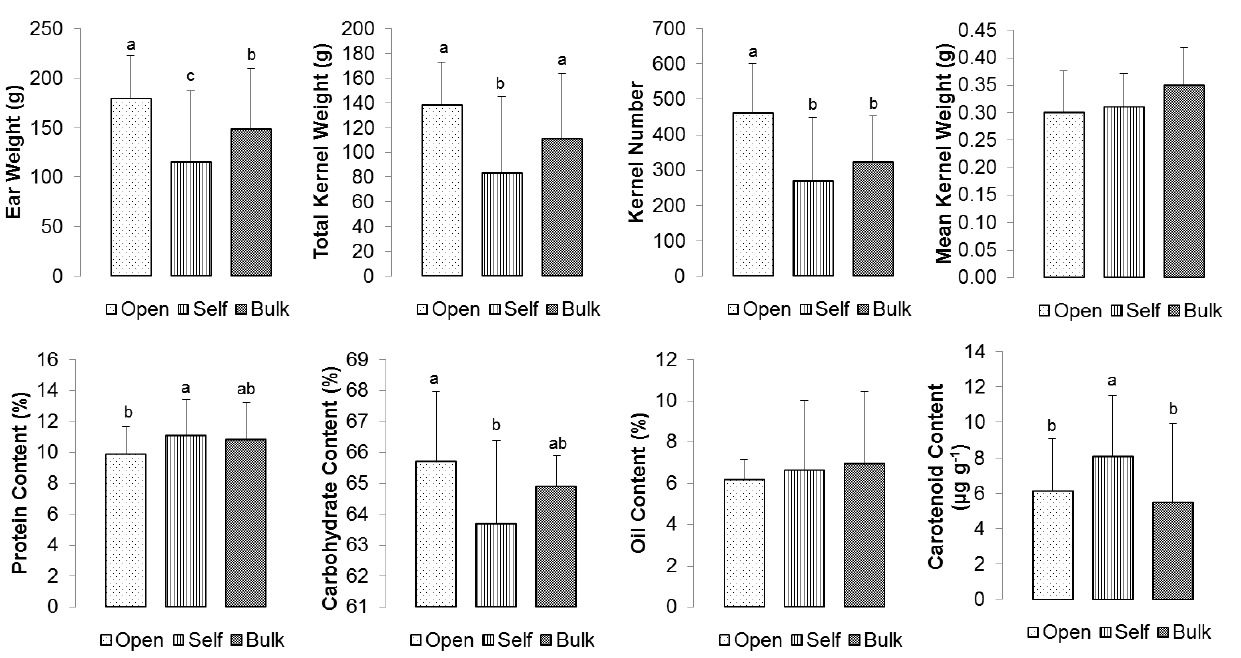
F IGURE 2. Differences among the pollination treatments (Open, Self, Bulk) for the investigated traits. Different letters among pollination treatments indicate the statistically significant differences at P < 0.05. Standard deviations are shown above the bars.